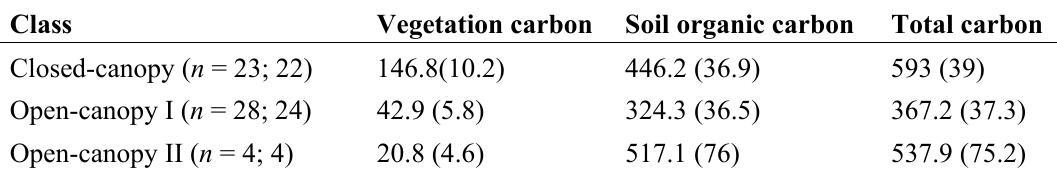
mangrove vegetation (dead and live, above and roots), soil organic carbon (SOC) and total carbon. Estimates are partitioned by strata. N represents the number of plots per class type, with two n values corresponding to trees and soil,